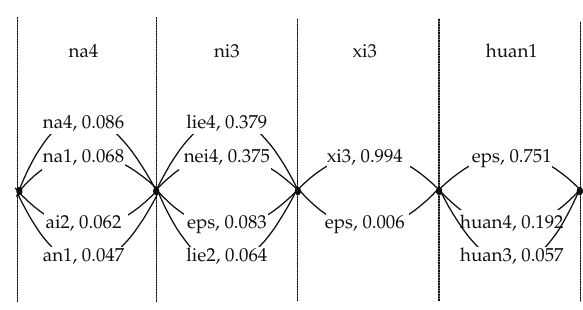
Figure 2: An example of confusion